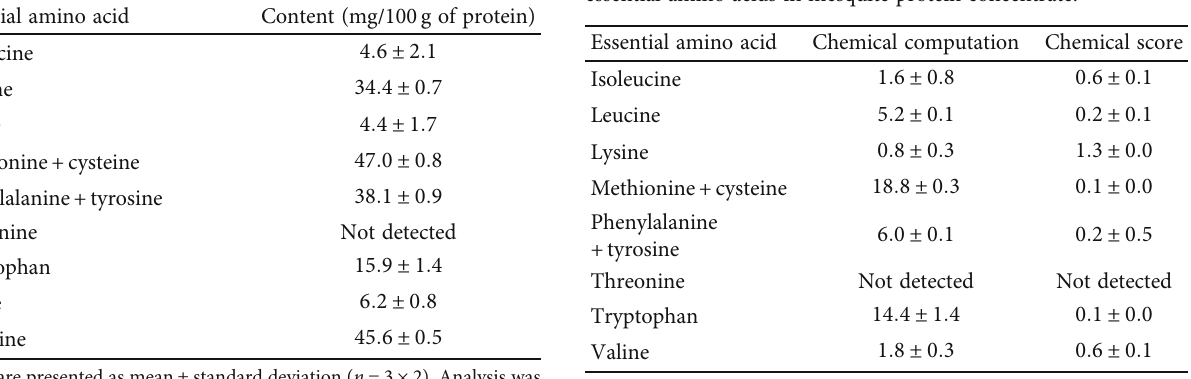
Table 3: Chemical computation and score on the composition of essential amino acids in mesquite protein